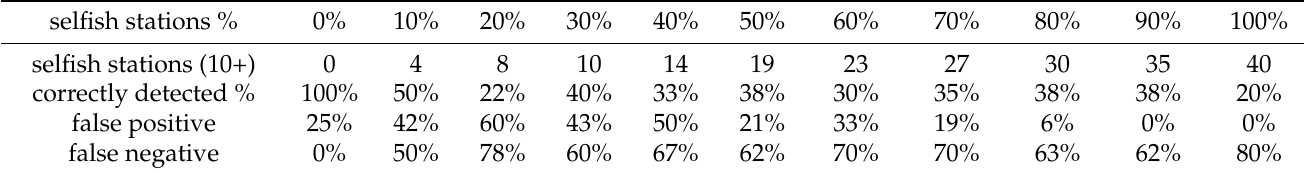
Table 8. ISSD detection for 50 stations with 2 slots in UDP scenario.